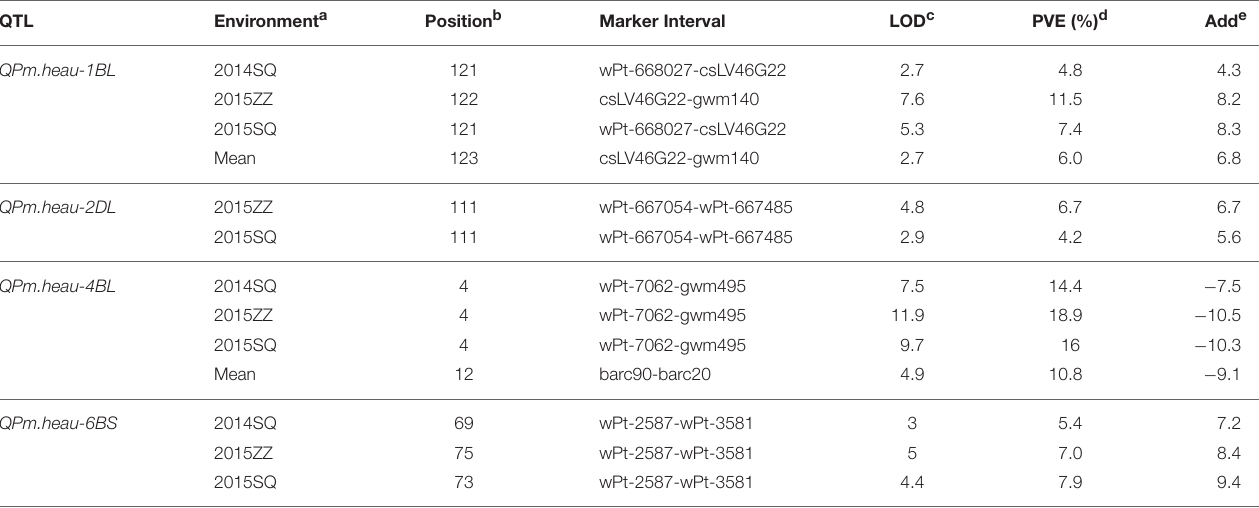
TABLE 2 | Quantitative trait loci (QTL) for adult-plant resistance to powdery mildew detected in Avocet × Quaiu#3 RIL population through bi-parental